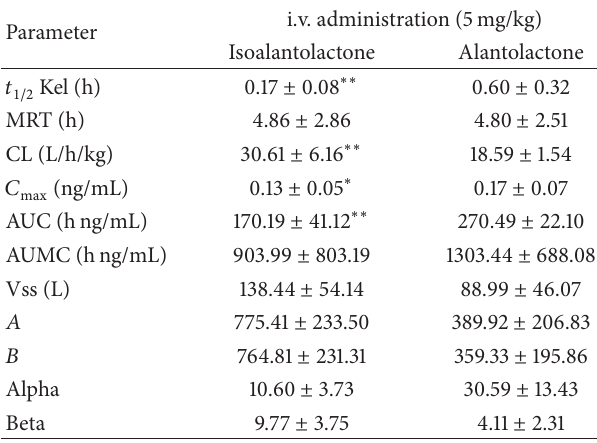
Table 5: Pharmacokinetic parameters of the lactones in rats a,b